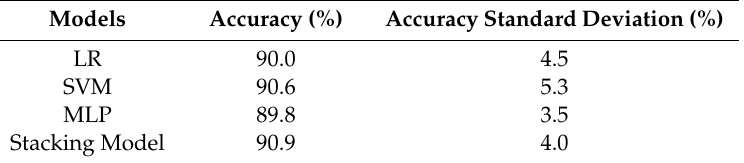
Table 5. The data test with di ff erent deep learning